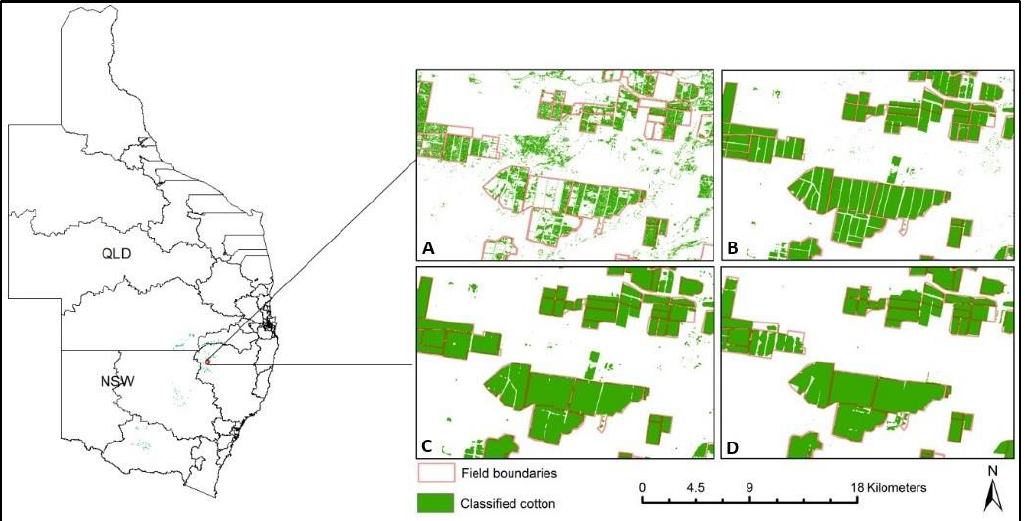
Figure 4. Zoomed-in maps (2013/2014 season) of some cotton fields using the leave-one-season-out cross validation (LOSOCV) technique. ( A ) the results of using harmonised Normalised Difference Vegetation Index (H-NDVI) only, ( B ) amplitude and phase only, ( C ) H-NDVI, amplitude and phase ( D ) H-NDVI, amplitude, phase and reflectance bands (1–11). Conversely, LOSOCV accuracies increased and errors decreased with the progress of the growing season. Moreover, the overall accuracy, kappa coe ffi cient, UA and PA increased with the addition of amplitude and phase in all three time periods as well as with the allocation of more information (with the progression of the season). It can be seen in Table 3 that the best results were obtained from the models trained on a combination of surface reflectance bands, amplitude, phase and H-NDVI, followed by models using amplitude, phase and H-NDVI and models that used only phase and amplitude. The poorest results were obtained when using only H-NDVI. Overall accuracies increased significantly as the season progressed from a mean of ~0.57 (early season) to a mean of ~0.97 when using all metrics as variables. Kappa coe ffi cients were very low for all three-time windows with a mean of ~0.12 when using only H-NDVI and a mean of ~0.46 when using all metrics (late season classification). The obtained kappa values are generally low even though classification is performed at late stages of plant growth, which means that relying on only H-NDVI to map cotton can be very di ffi cult and not reliable. UA was high in the three time periods and for all four models except when using the H-NDVI, which produced relatively lower UA. PA recorded lower accuracies in the early season models. Commission and omission errors were also high at the early stages of classification. However, these errors were reduced significantly with the progress of the growing season and this is not surprising, since more classes were classified correctly at the mid and late